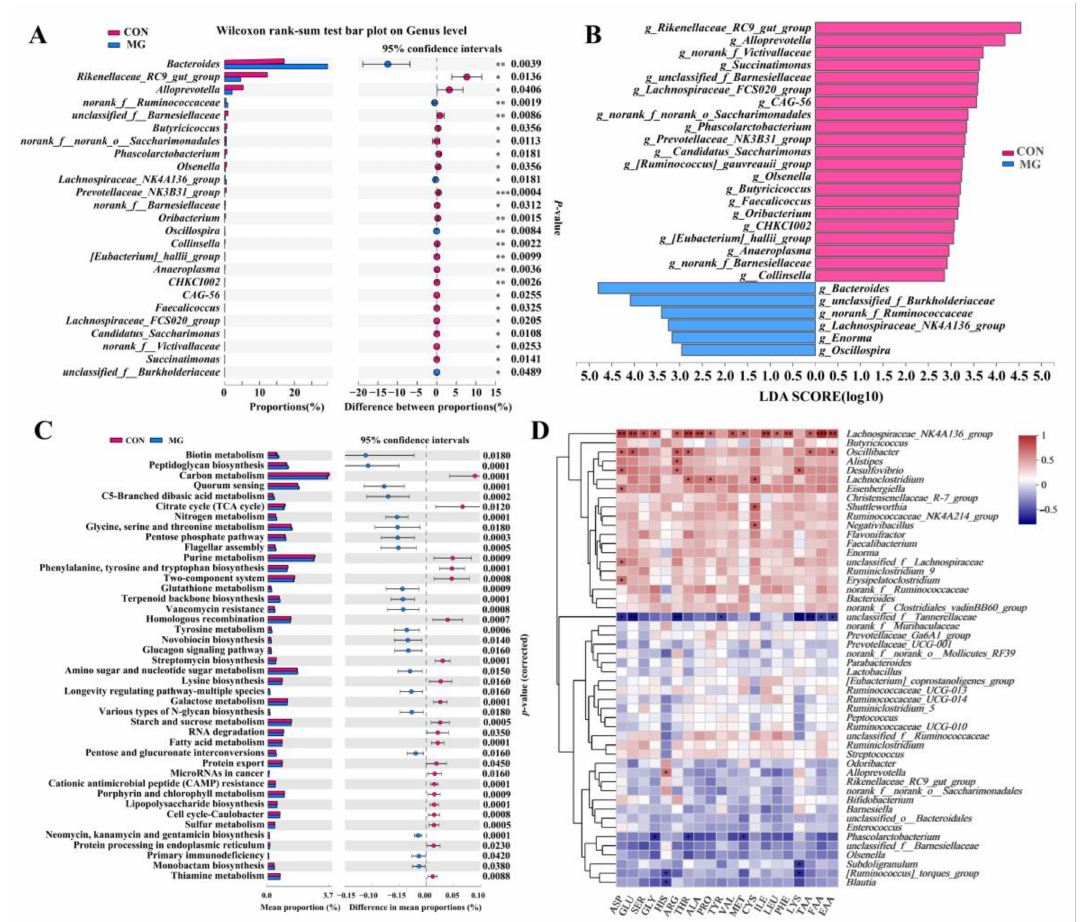
Figure 5. Changes in chicken gut microbiota and predicted function with MG